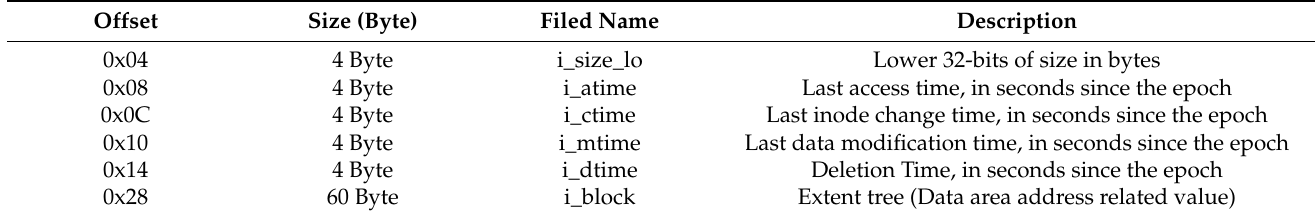
Table 1. Main structure of inode related to file recovery.